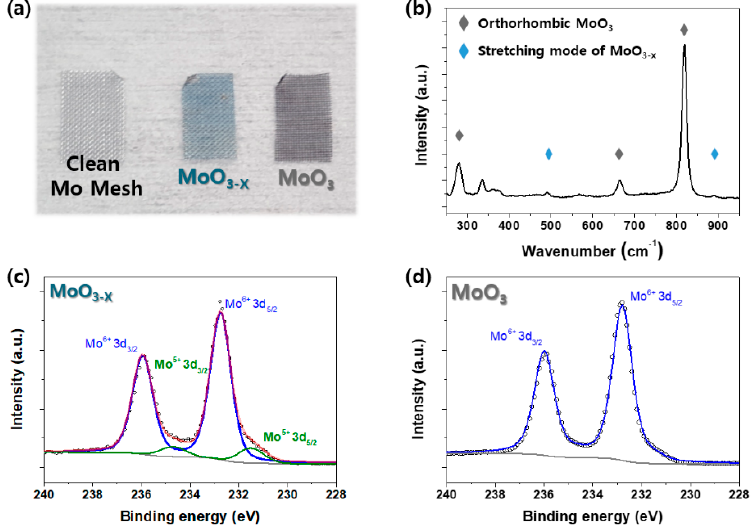
Figure 3. ( a ) Real photo images of the clean Mo mesh, MoO 3 − X , and MoO 3 electrodes. ( b ) Raman spectra of MoO 3 − X . Mo 3d X-ray photoelectron spectroscopy (XPS) spectra of ( c ) MoO 3 − X and ( d ) MoO 3 .